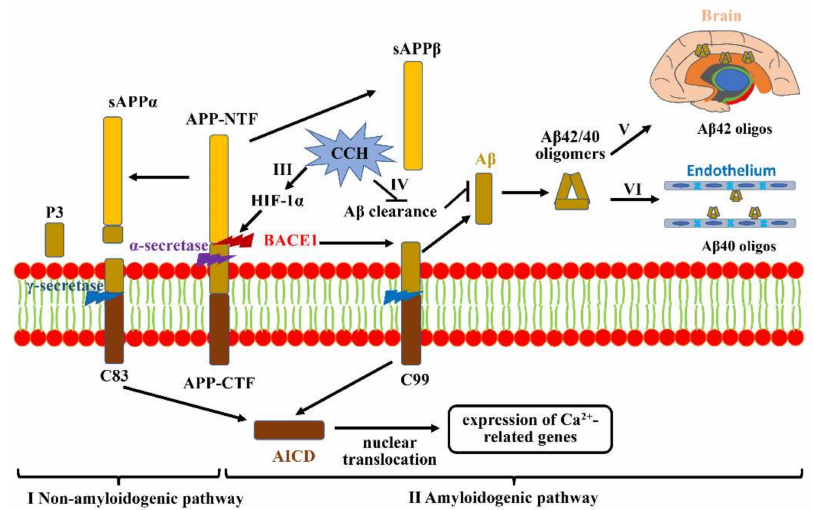
Figure 1. A β accumulation and aggravation under CCH. ( I ) Non-amyloidogenic pathway: APP